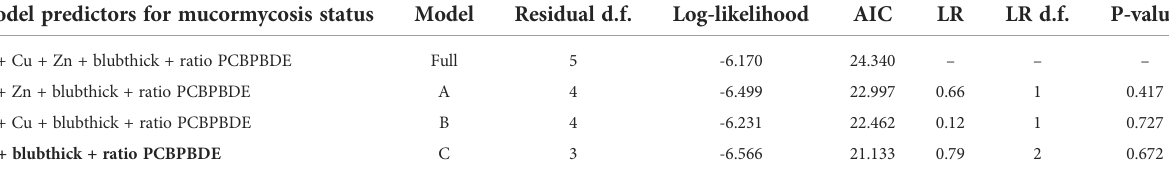
TABLE 1 Evaluation of conditional logistic regression models of mucormycosis case status (case or control). Model predictors for mucormycosis